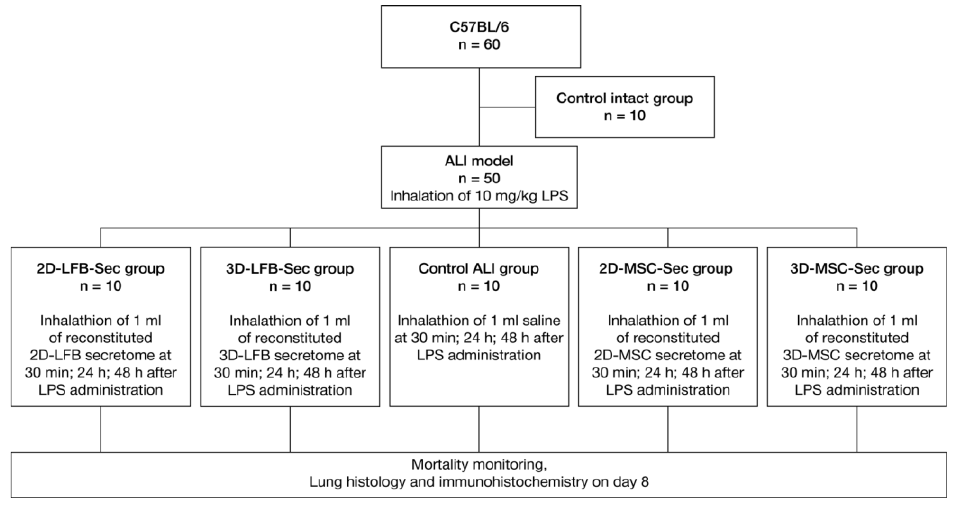
Figure 1. Flow chart of the study. ALI, acute lung injury; LPS, lipopolysaccharide; MSC, mesenchymal stromal cell; LFB, lung